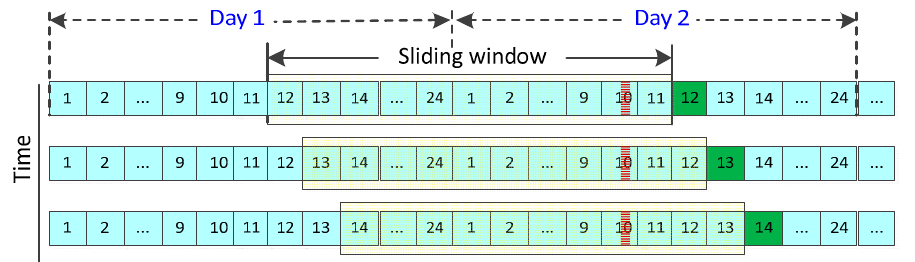
Figure 3. The 24-h sliding window in the precise orbit determination (POD). The red shadow stands for the maneuver period, the yellow rectangle represents the 24-h sliding window, and the green rectangle denotes the period for which the broadcast ephemeris is generated.